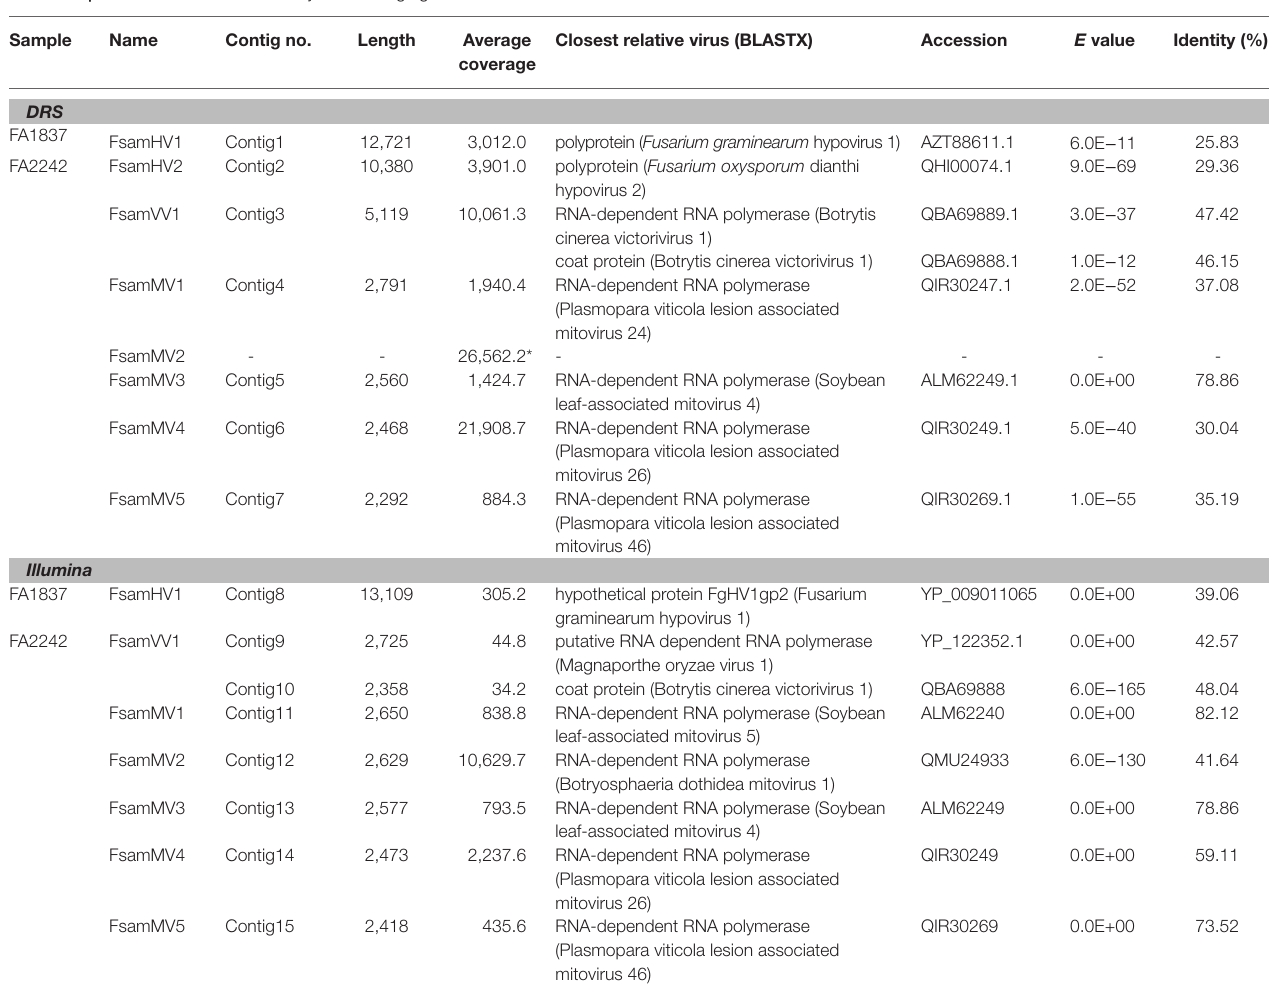
TABLE 2 | Results of the BLASTX analysis of contigs generated from DRS and Illumina reads.